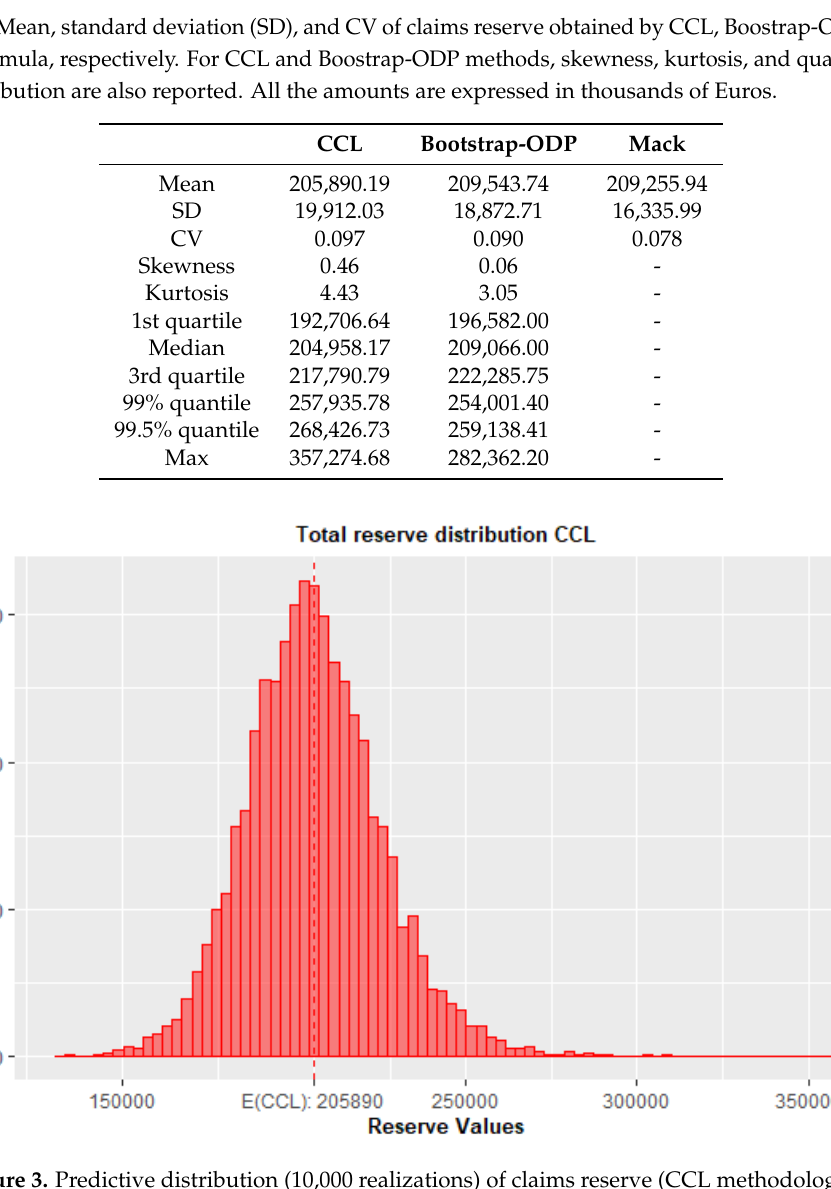
Figure 3. Predictive distribution (10,000 realizations) of claims reserve (CCL